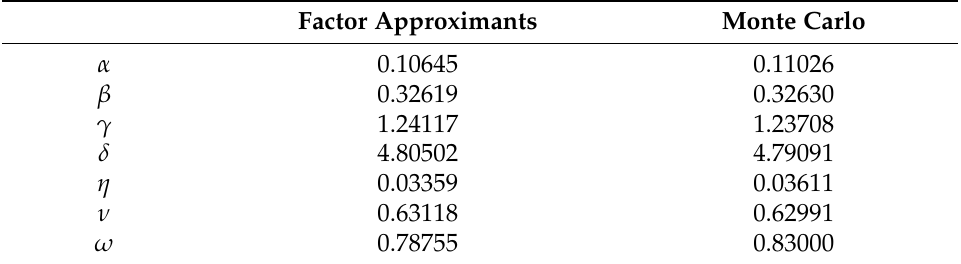
Table 3. Critical exponents for the O ( 1 ) -symmetric ϕ 4 field theory of the Ising universality class calculated using self-similar factor approximants, as compared with Monte Carlo